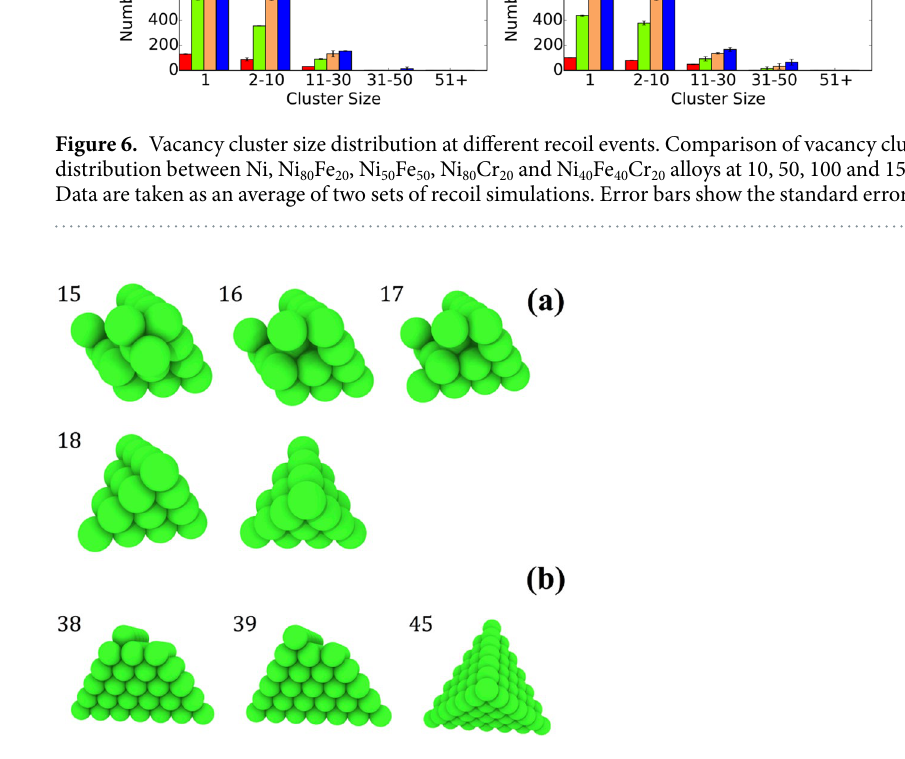
Figure 7 shows the evolution of vacancy clusters to form SFT in Ni 80 Fe 20 and elemental Ni. After the 15 th recoil in Ni 80 Fe 20 (Fig. 7a), a vacancy cluster is formed with one well-defined {111}-side plane. No vacancy cluster was found to exist for fewer recoils, so this cluster formed entirely during the 15 th recoil event. After some rearrange- ment of vacancies following the 16 th and 17 th consecutive recoils, a perfect SFT with an edge length of four vacan- cies forms during the 18 th recoil. Figure 7b presents irradiation-assisted formation of similar vacancy-like SFT in Ni with an edge length of seven vacancies. Other binary and ternary alloys produce truncated SFT. Besides single isolated SFT, some coupling of SFT along an edge length or a plane are also observed. It is important to note that only a small fraction of defects produce perfect SFT. Other defects consist of isolated point defects, defect clusters and truncated SFT. A few studies have been carried out to understand the formation mechanism of SFT in fcc metals during ion irradiation by MD simulation 39, 40 . In particular, Nordlund et al . have shown that, in fcc Cu and Au, SFT can form directly in the atom-depleted zone at the center of a collision cascade by four intersecting {111} vacancy stacking faults and simultaneous atom rearrangement 39 . The SFT observed in the current study can also be described using this method due to the simulation conditions and features of the SFT. Experimentally, SFT are